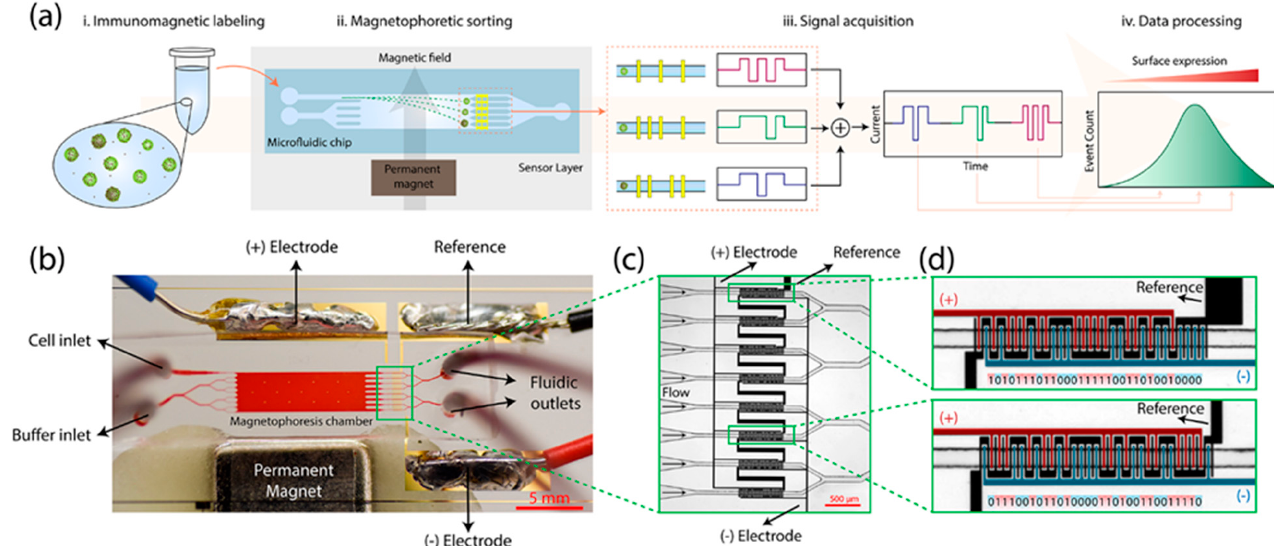
Figure 12. Magnetophoretic flow cytometer. ( a ) Operation principle. ( b ) Image of the microfluidic device. ( c , d ) Microscopy images of the electrical sensors for in-line quantification. Reproduced with permission [103]. Copyright 2019 RSC.